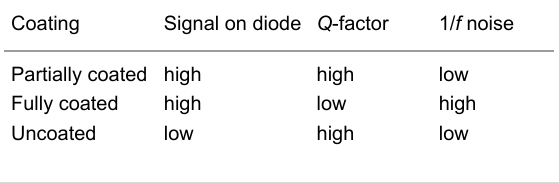
Table 2: Summary of the performance of cantilevers with different coating. The partially coated cantilever combines the advantages of the fully coated with the advantage of the partially coated cantilever.